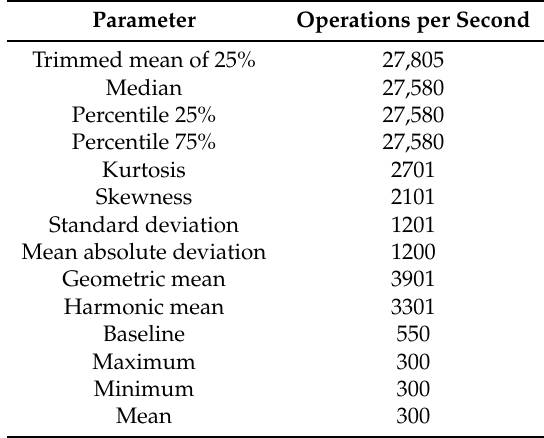
Table 3. List of statistics and number of operations per second required.